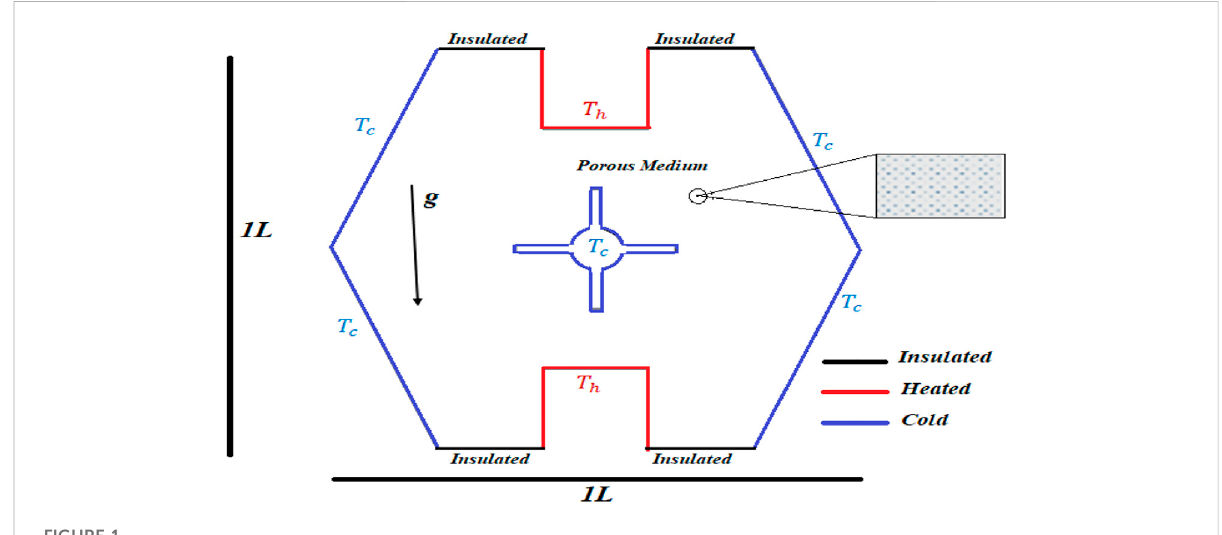
FIGURE 1 Diagrammatic representation of the